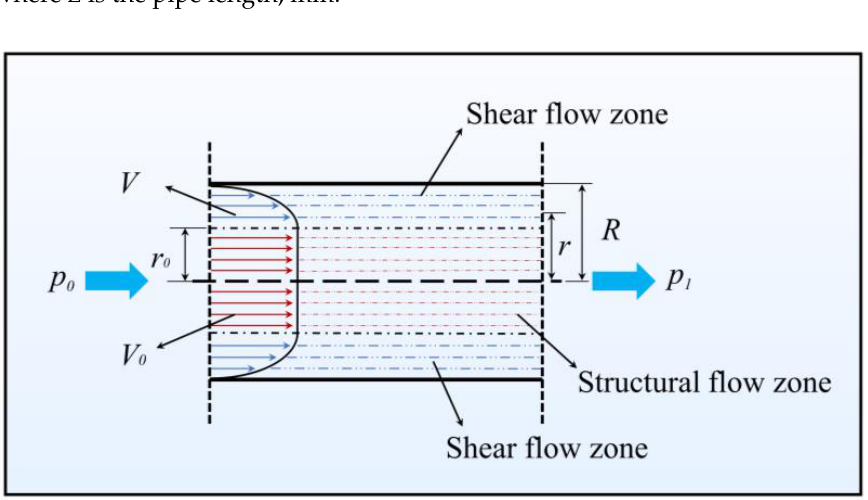
Figure 1. Flow model of UCPB in pipe [45,46].